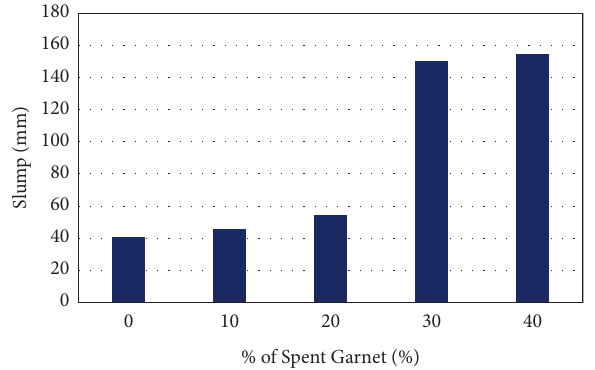
Figure 5: Slump value of POC LWAC containing spent garnet.